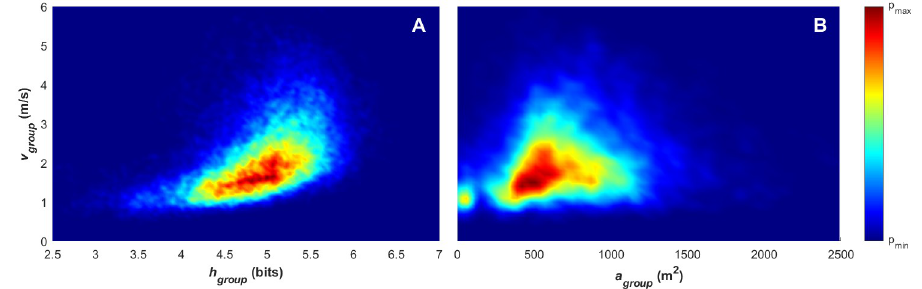
Fig 6. (A) Density plot for paired values of group entropy ( H group ) and polarisation ( p group ), and (B) surface area ( A ) and mean group speed ( � u group